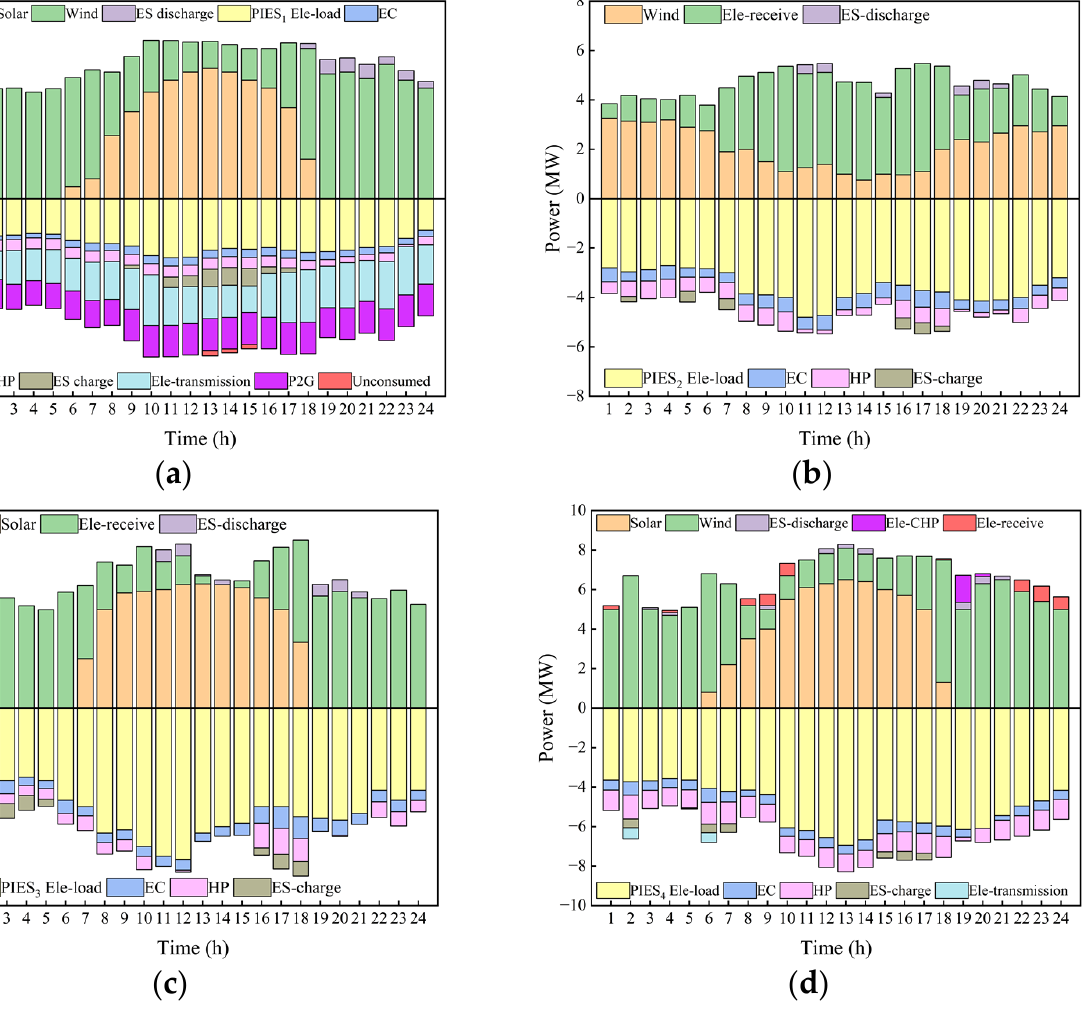
Figure 15. Electric network of each park of the RIESG: ( a ) PIES 1 electrical network; ( b ) PIES 2 electrical network; ( c ) PIES 3 electrical network; ( d ) PIES 4 electrical network.